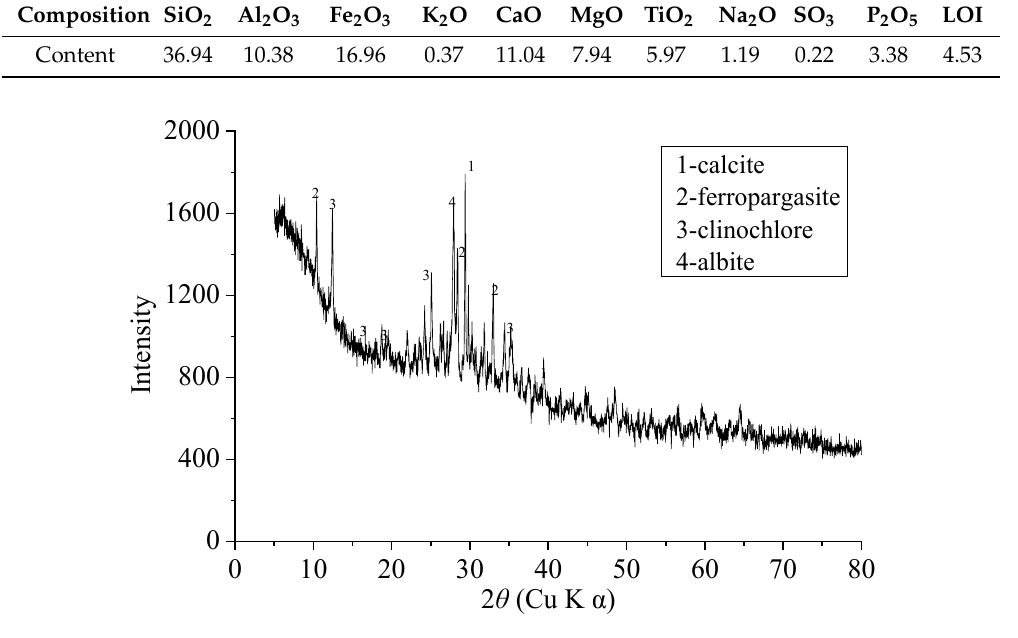
Figure 2. Mineral composition of iron tailings sand.